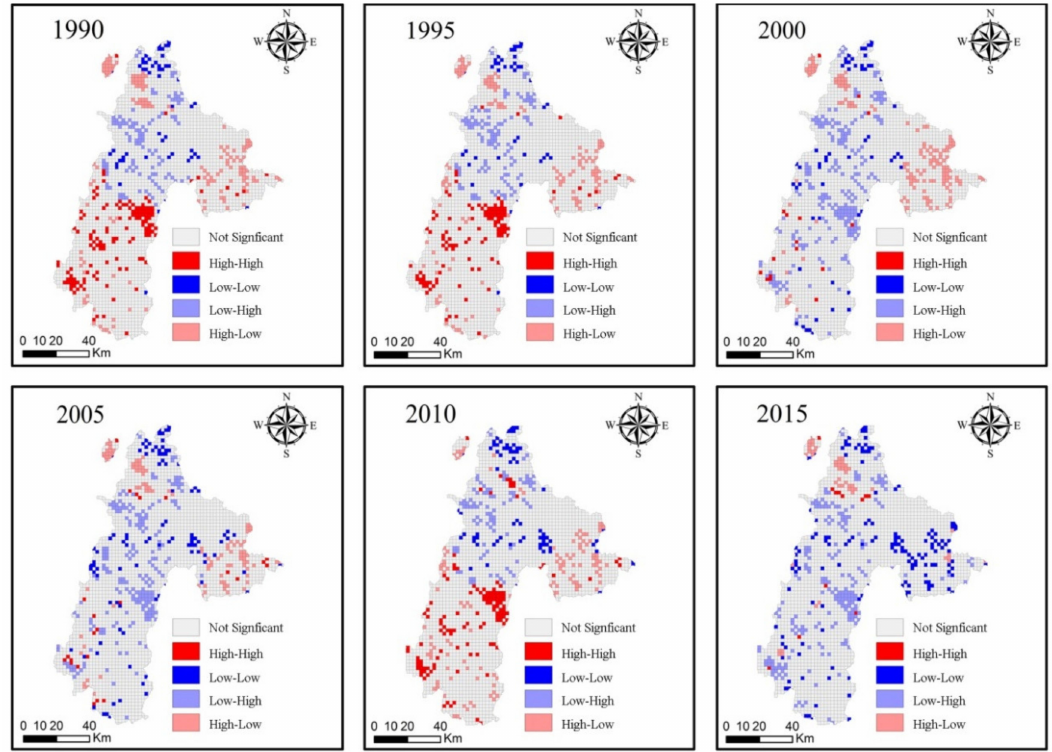
Figure 5. LISA cluster maps between ecosystem health (ESH) and urbanization level; High–High: High Urbanization and High ESH; Low–Low: Low Urbanization and Low ESH; Low–High: Low Urbanization and High ESH; High–Low: High Urbanization and Low